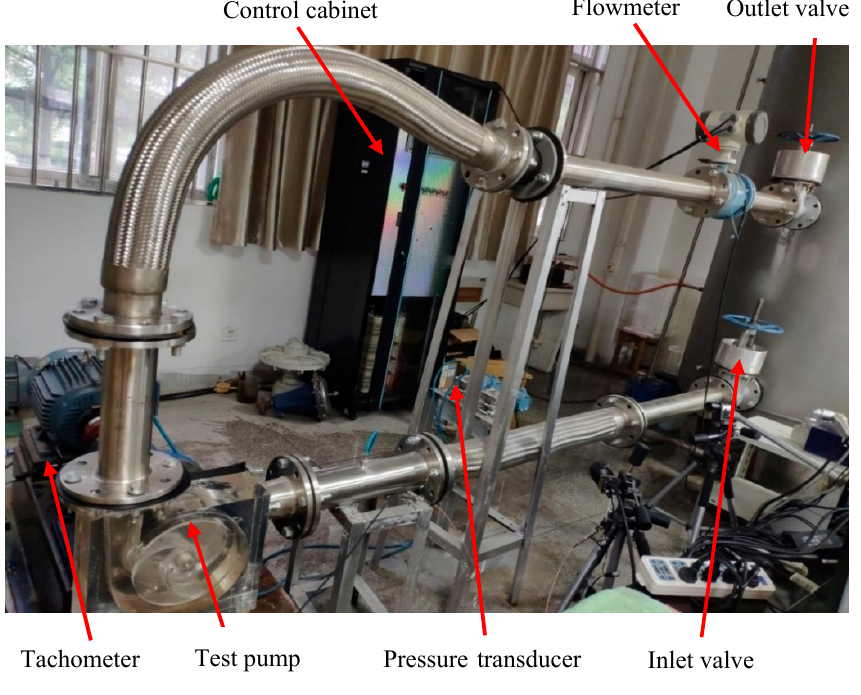
Figure 3. Test rig. Table 4. Instruments of the test rig.